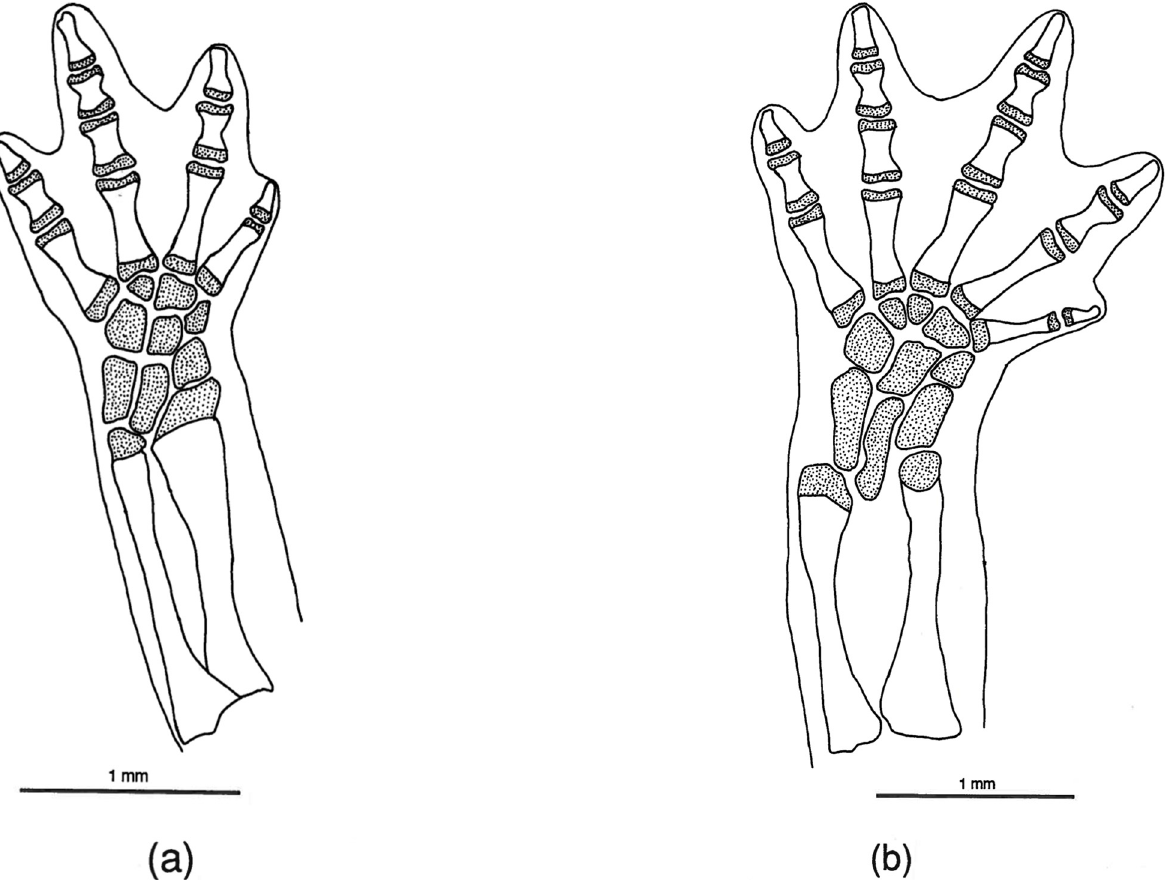
Fig 9. Chiropterotriton dimidiatus feet. Drawings of front, left (a) and rear, left (b) feet of Chiropterotriton dimidiatus (MVZ 185965), showing skeletal elements and the extent of interdigital webbing. Dorsal view; stippled areas represent cartilage. Elements as labeled in Fig